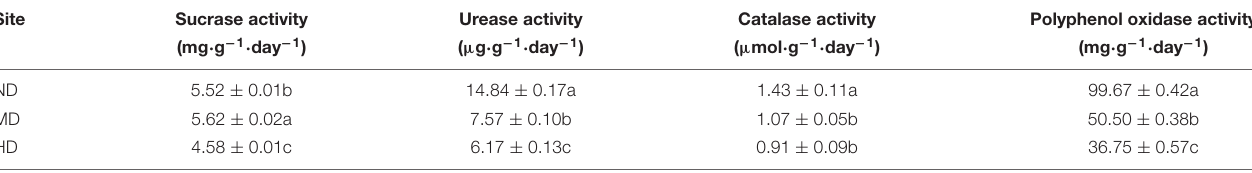
TABLE 3 | Soil enzymatic activity in the three konjac growing sites affected by different levels of soft rot disease.